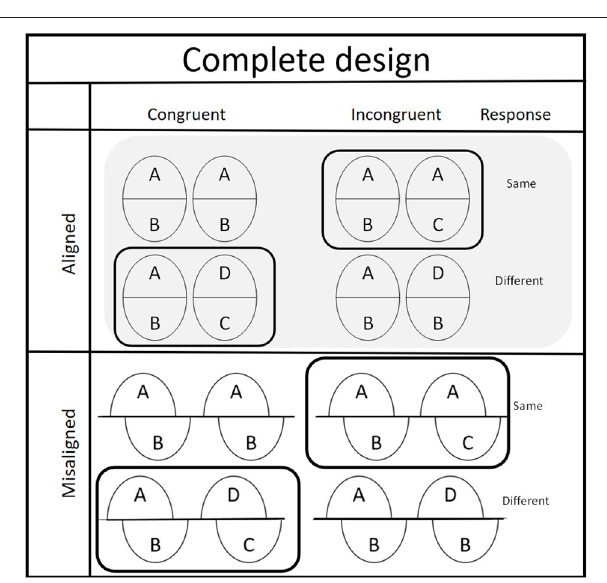
FIGURE 2 | The figure depicting the complete design of composite-face task was redrawn from Gauthier and Bukach (2007).